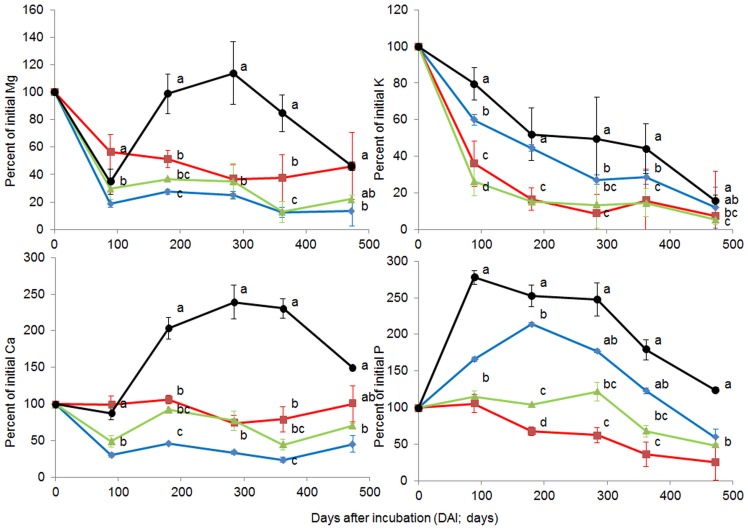
Percent of initial magnesium (Mg), potassium (K), calcium (Ca) and phosphorous (P) during decomposition under different forest system management practices.Norway spruce age-class forest (blue, SA), European beech age-class forest (red, BA), European beech selective cut forest (green, BS) and unmanaged deciduous forest reserves dominated by European beech (black, BU) (mean ± SD, n = 3). Different letters indicate significant differences according to one-way ANOVA incorporating Fisher’s Least Significant Difference (from 89 DAI to 473 DAI).